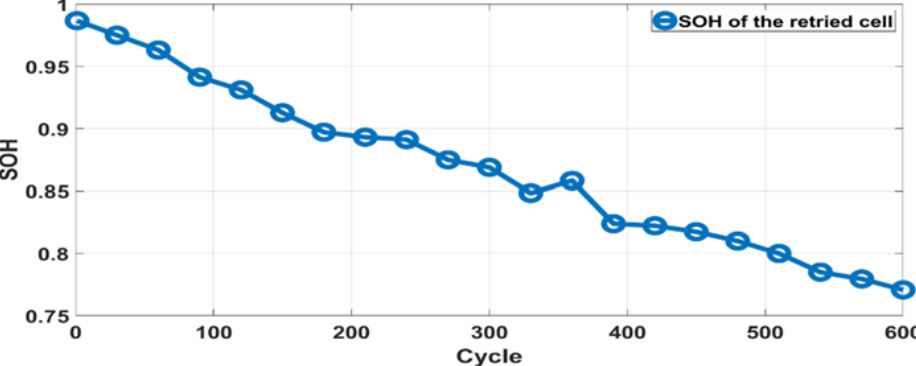
Figure 25. SOH of the retired cell according to the 1C ‐ rate CC ‐ CV aging cycle test (600 times).